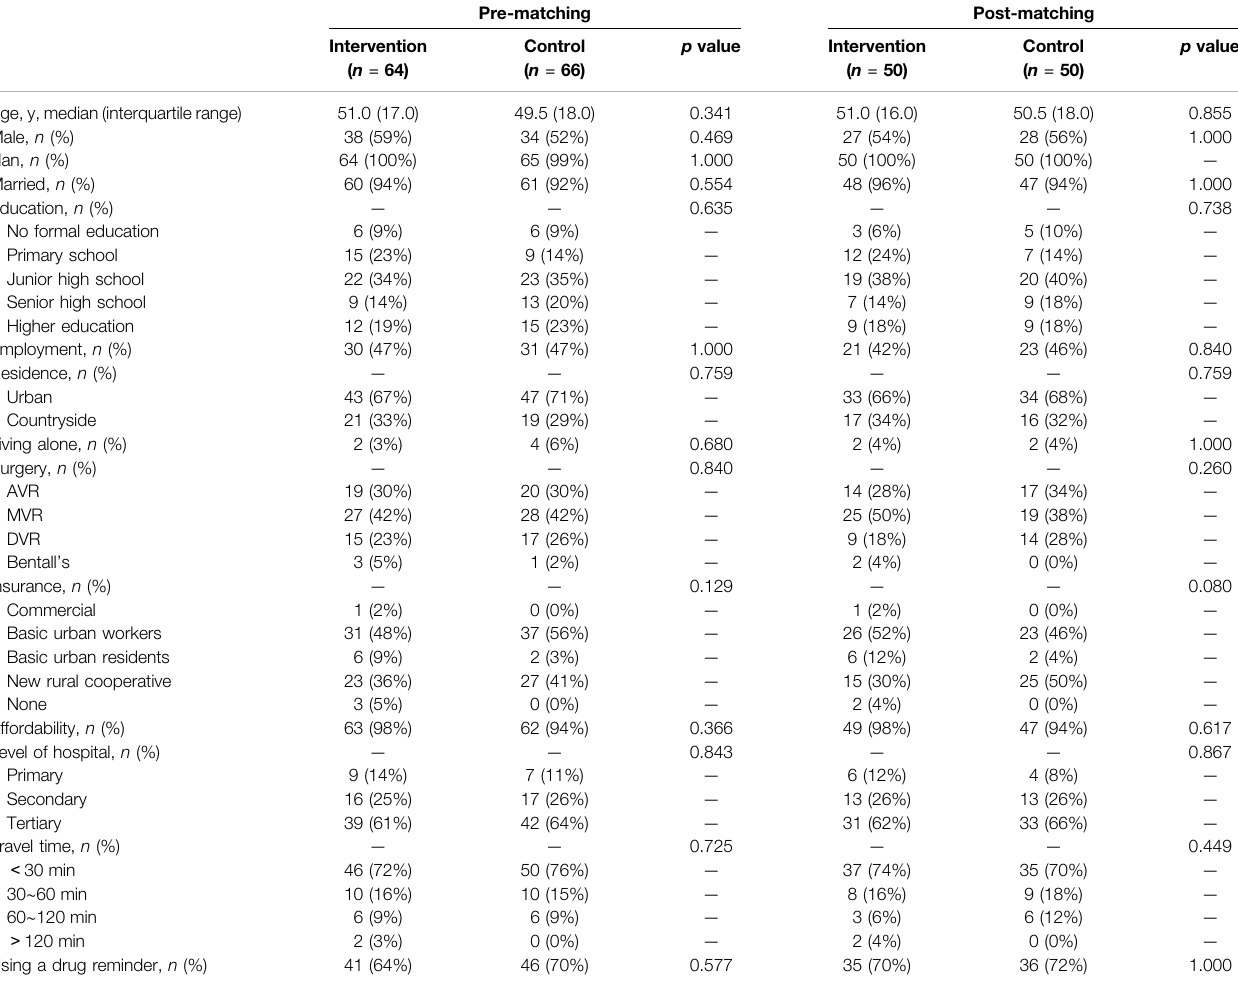
TABLE 1 | Baseline Characteristics of enrolled patients before and after propensity-score matching.